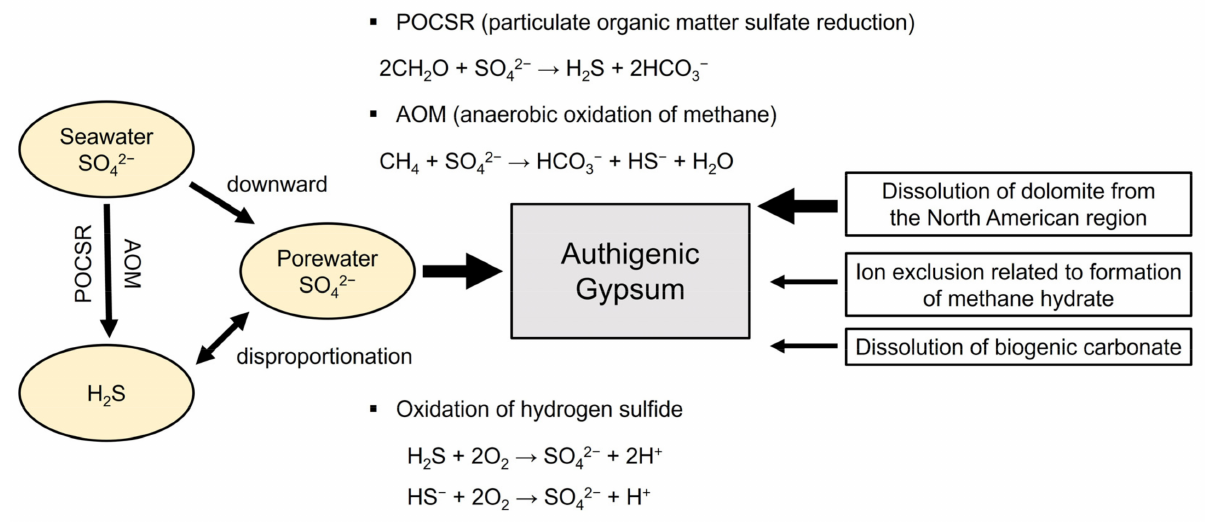
Figure 7. Schematic figure of the sulfur cycle and Ca sources for precipitation of authigenic gypsum; modified, Lin et al.